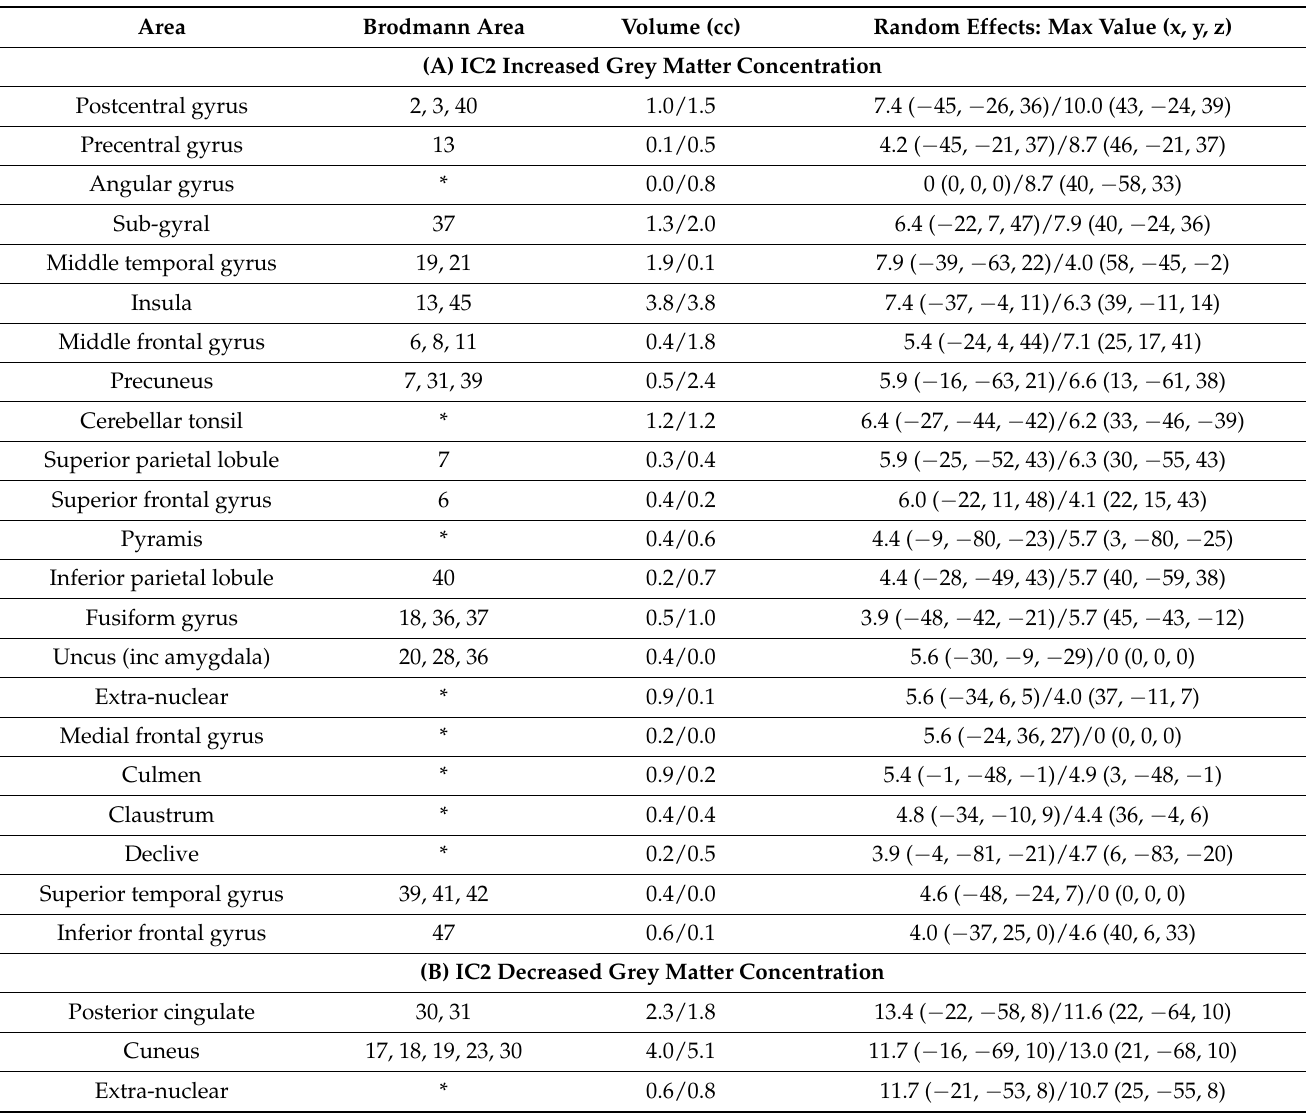
Table 2. Brain areas of IC2